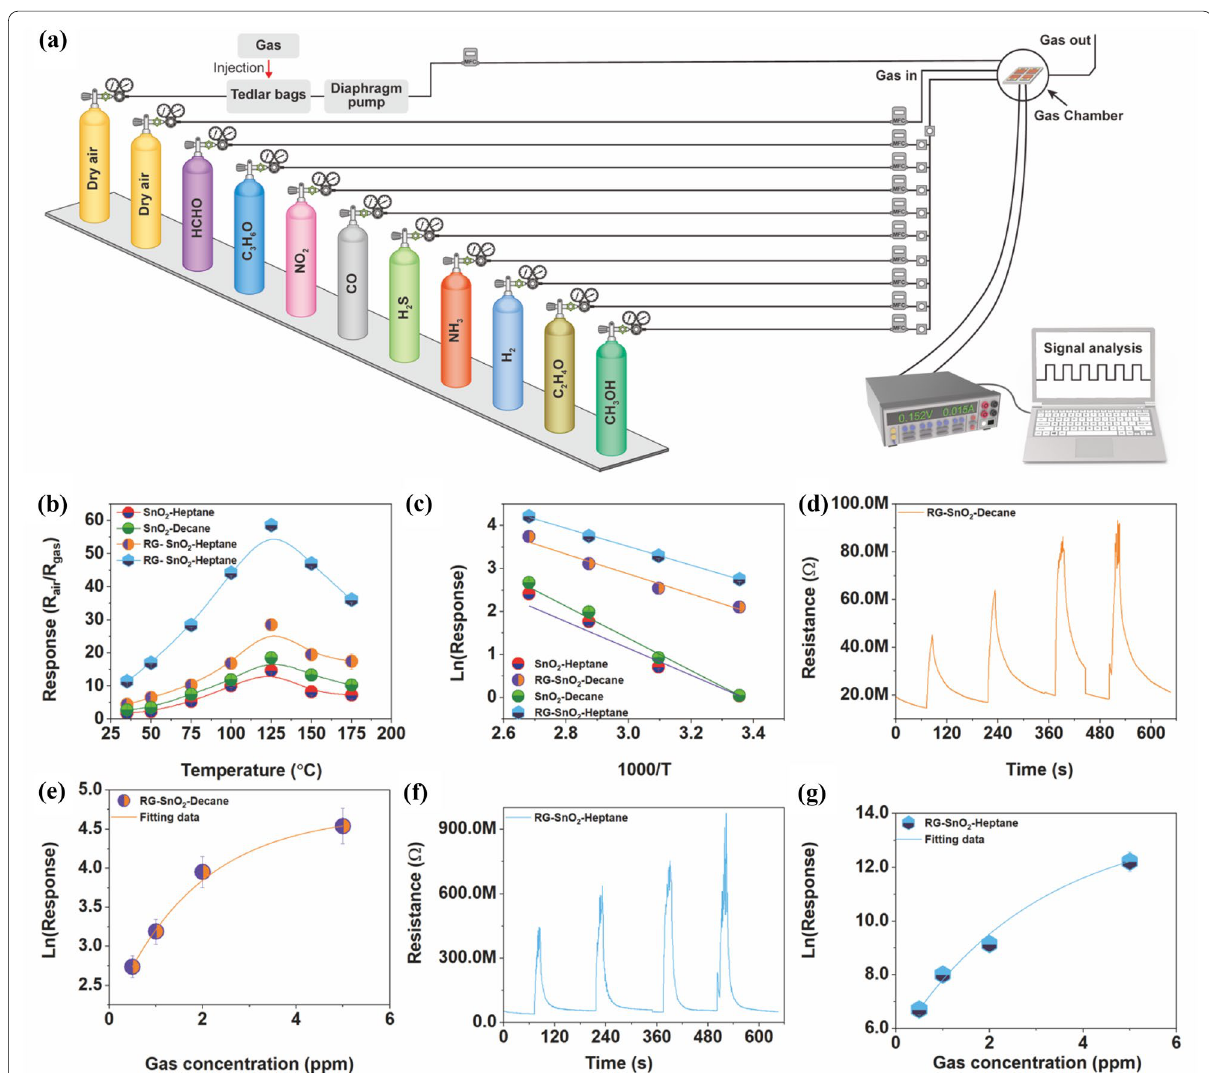
Fig. 4 Heptane and decane sensing characteristics of the sensors based on SnO 2 nanospheres and reduced graphene oxide incorporated SnO 2 nanospheres. a Schematic diagram of the gas sensing measurement system. b Temperature‑dependent sensing characteristics of the sensors to 4 ppm of heptane and decane and c corresponding Arrhenius sensing response of the sensors. d , f Dynamic heptane and decane sensing characteristics of the sensors based on